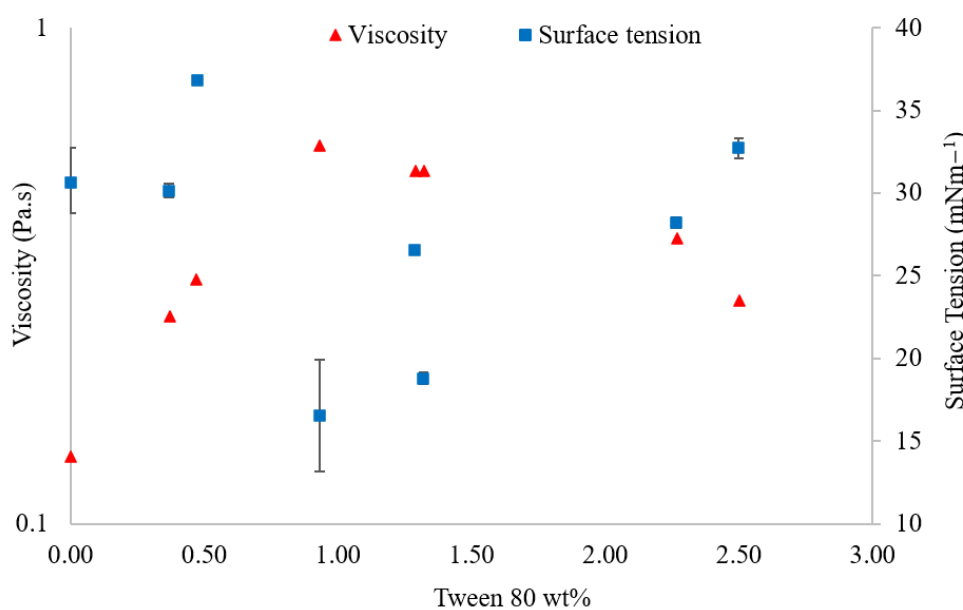
Figure 8. Viscosity (Pa.s) (red triangle) and surface tension (mNm − 1 ) (blue square) variation with differing Tween 80 concentrations. For each formulation, two measurements were recorded for the contact angle and capillary height used to calculate the surface tension. The error bars represent the lowest and highest surface tensions calculated from these results to generate an impression of the error of the measurement technique.